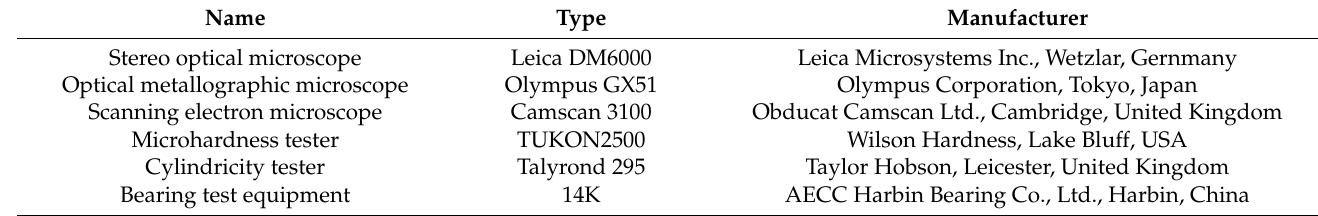
Table 4. Experimental instruments and equipment used in this